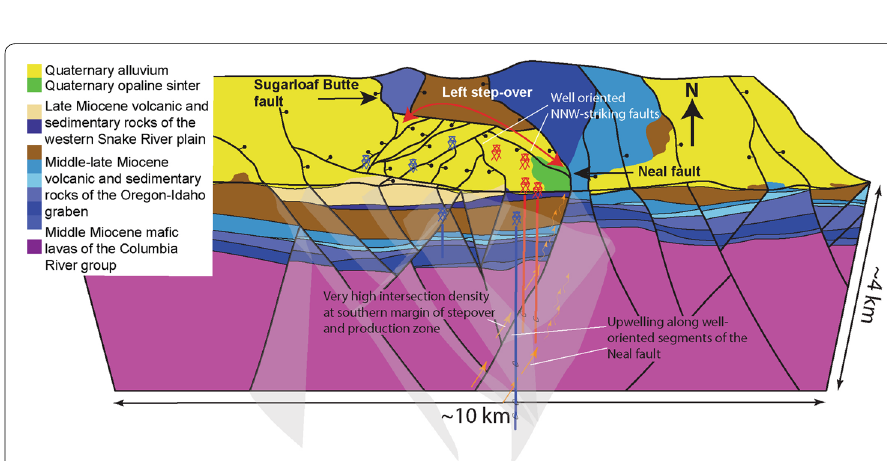
Fig. 15 Conceptual model of fluid upwelling at Neal Hot Springs. Fluids upwell (orange arrows) along favorably oriented (in the current stress field), NNW-striking, moderately to steeply dipping fault segments of the Neal fault and/or fault intersections at the southeastern end of the step-over, as evidenced by the location of the production wells in this area. The opaline sinter terrace (green) marks the surface manifestation of the upwelling geothermal